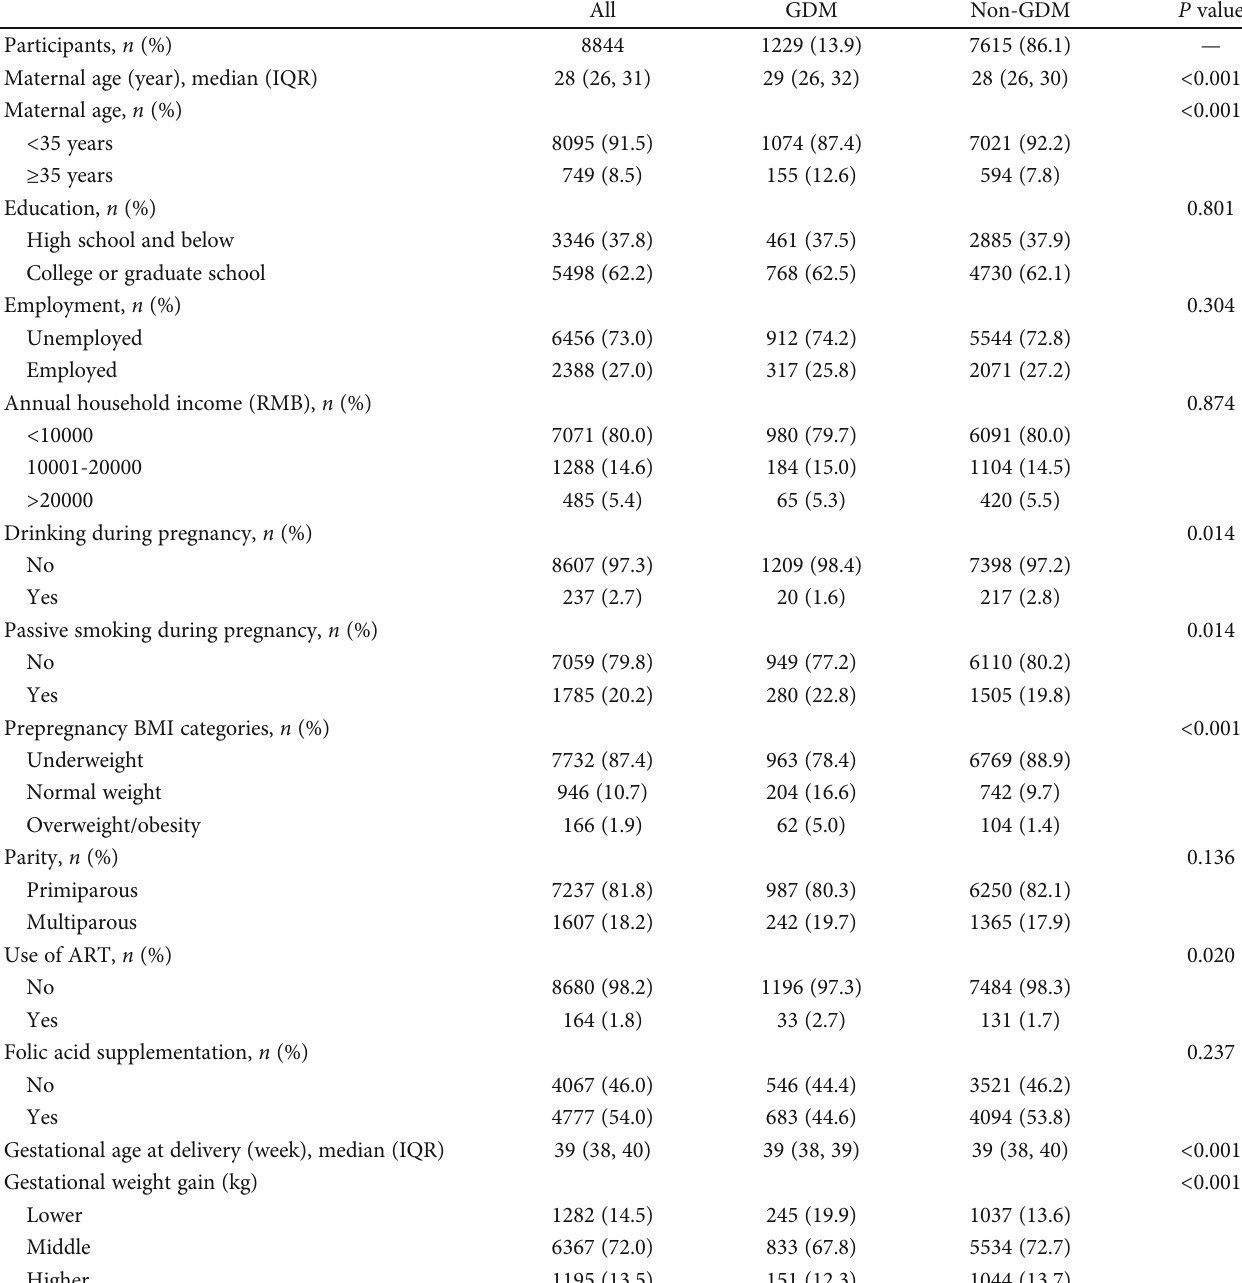
Table 1: Characteristics of participants by gestational diabetes